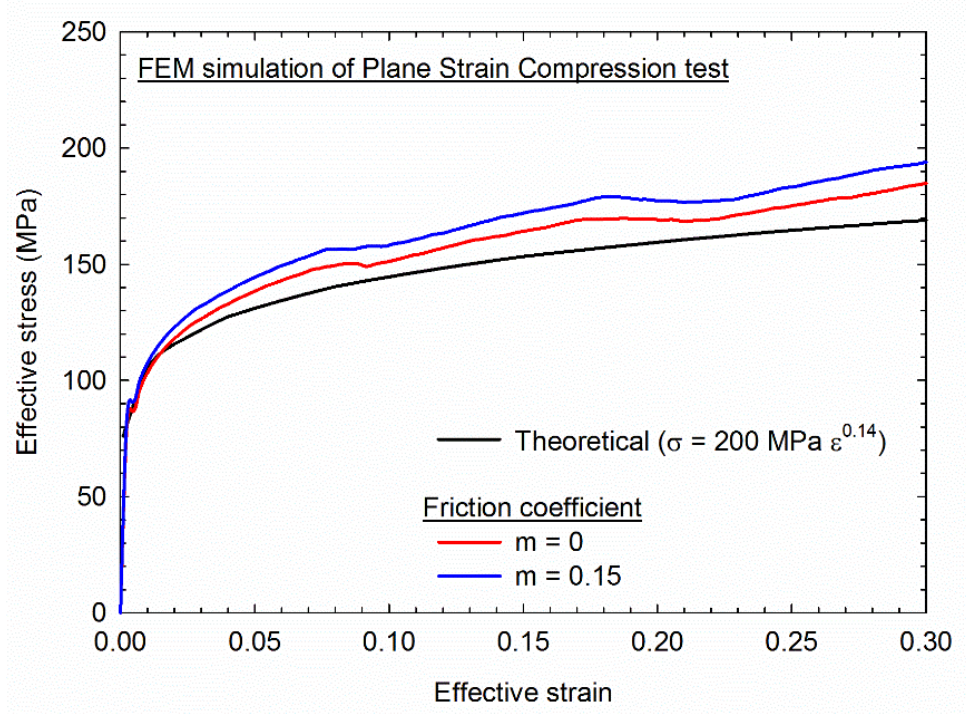
Figure 6. Stress vs. strain curves obtained from the PSC simulations considering different friction conditions, the theoretical input curve is also shown for comparison.